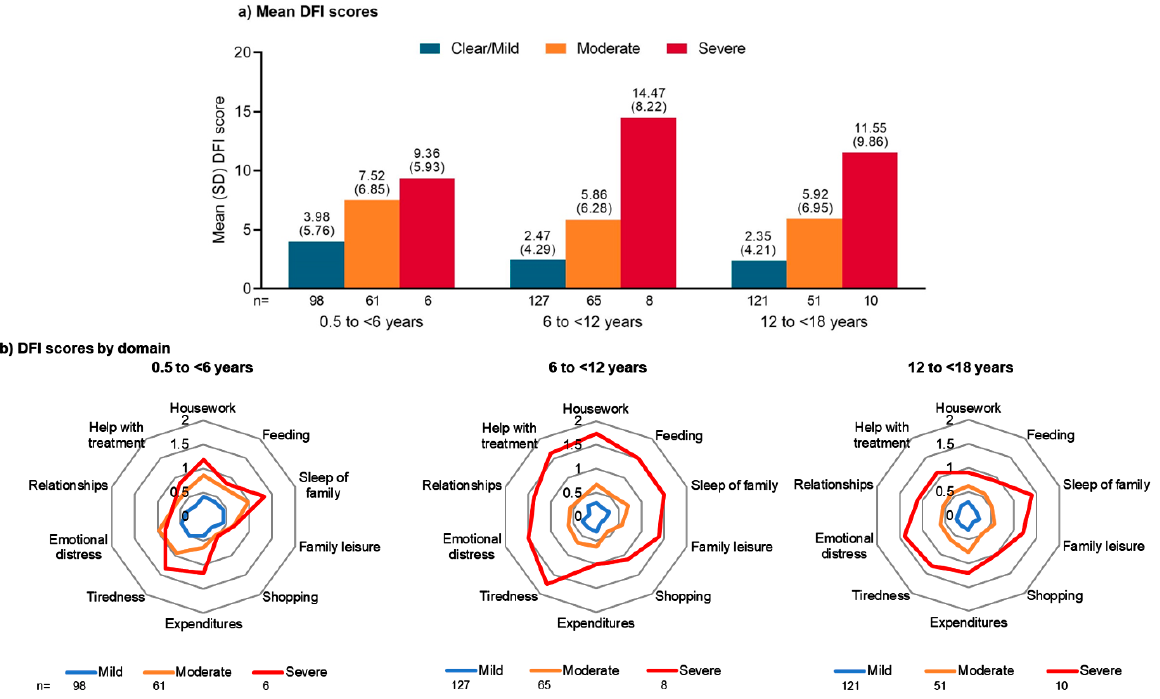
Figure 1. ( a ) Mean dermatitis family impact (DFI) scores according to POEM severity of atopic dermatitis in Japanese pediatric patients across age groups; ( b ) distribution of DFI domain scores across age groups. DFI, dermatitis family impact; POEM, patient-orientated eczema measure; SD, standard deviation.